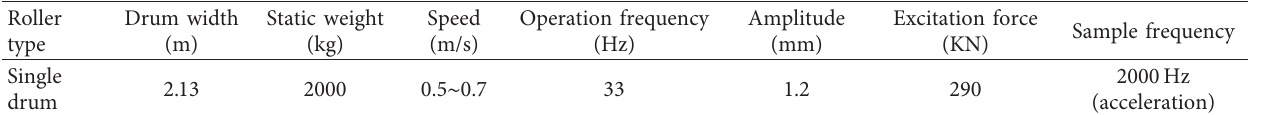
Table 3: Details of equipment.